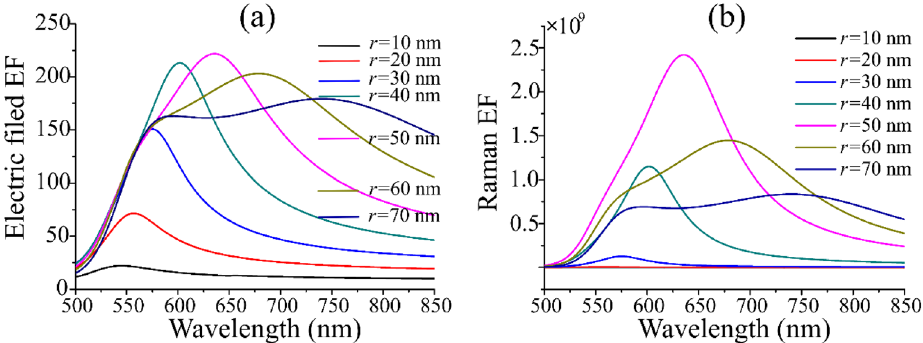
Figure 3. The dependence of the electric field enhancement factor ( a ) and Raman enhancement factor ( b ) of Au dimer on with the variation of incident light wavelength at different radius. Here the incident angle is set as 0°, the distance of Au nanoparticles is 2 nm, and the excitation wavelength is set as 635 nm.